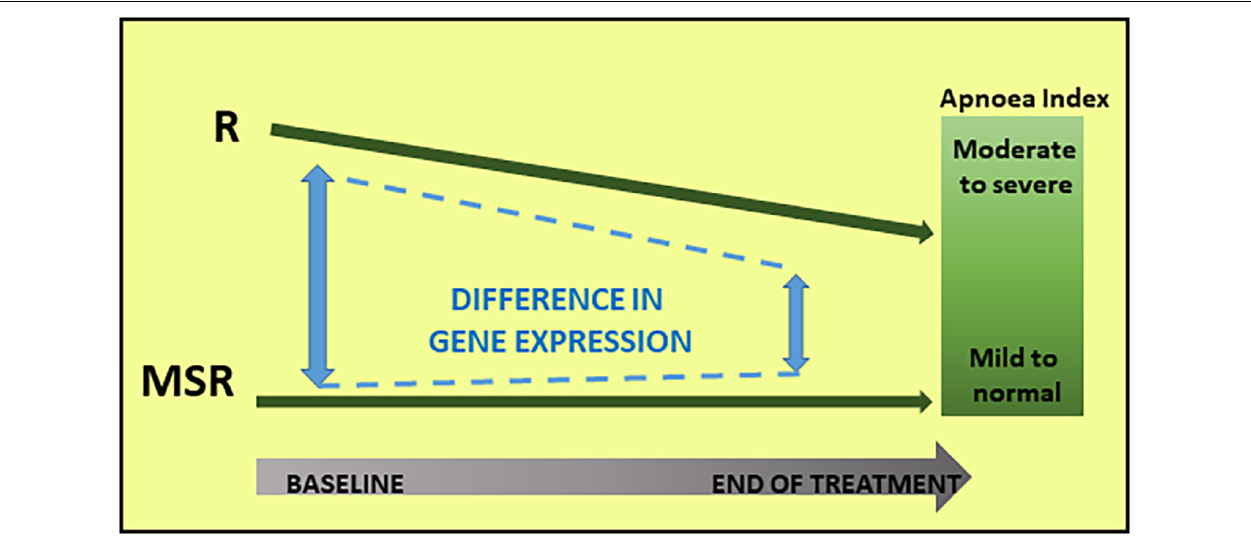
FIGURE 3 | Molecular and phenotypic changes in Responder (R) and Mecasermin Study Reference (MSR) groups throughout the study. Based on their breathing phenotype, the cohort was divided into two groups: Responder and MSR groups. The R group, including participants with moderate to severe breath holding phenotype, responded to mecasermin administration by decreasing their apnoea index. Because of their virtual lack of breath holding phenotype, those in the MSR group experienced minimal changes. In parallel to these changes in breathing phenotype in the R group, there was a decrease in group differences in transcript profiles (i.e., significant at baseline) throughout the